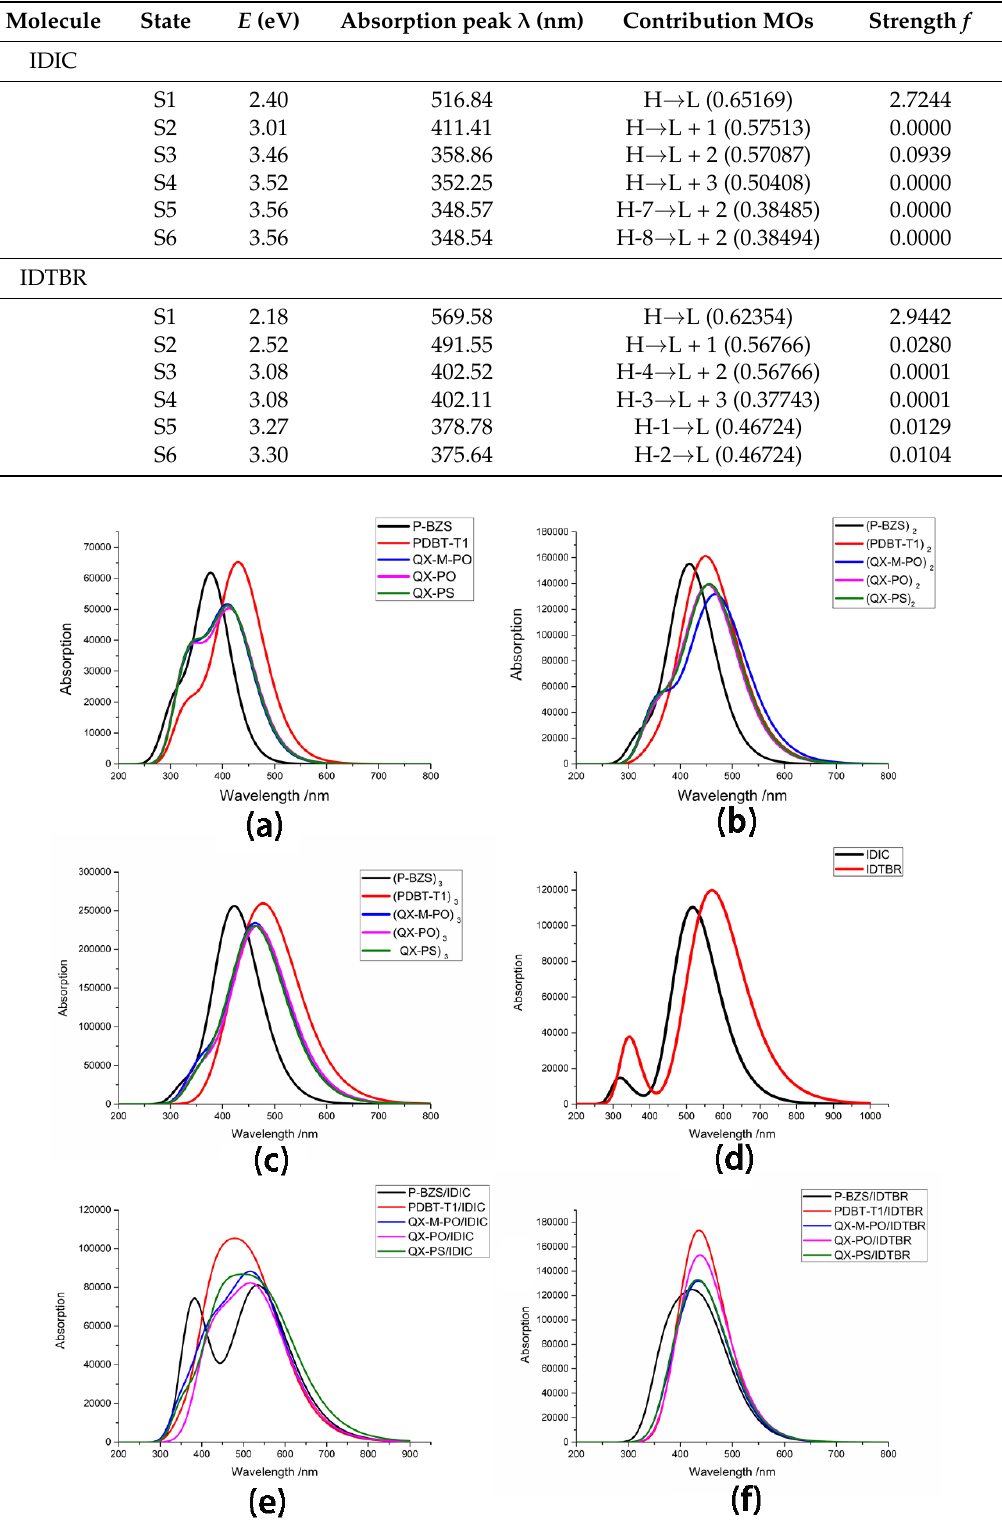
Table 7. Transition energies and oscillators strengths for the NFAs (IDIC, IDTBR). Molecule